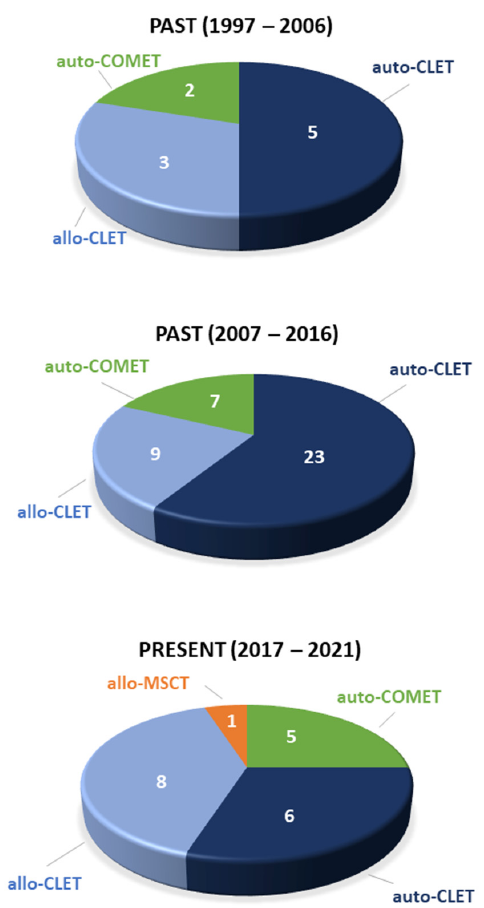
Figure 5. Evolution of stem cell-based therapies to treat corneal failure due to limbal stem cell deficiency from 1997 until the present. The data are for only published clinical trials. CLET, cultivated limbal epithelial transplantation; COMET, cultivated oral mucosal epithelial cell transplantation; MSCT, mesenchymal stem cell transplantation; auto, autologous; allo, allogeneic.